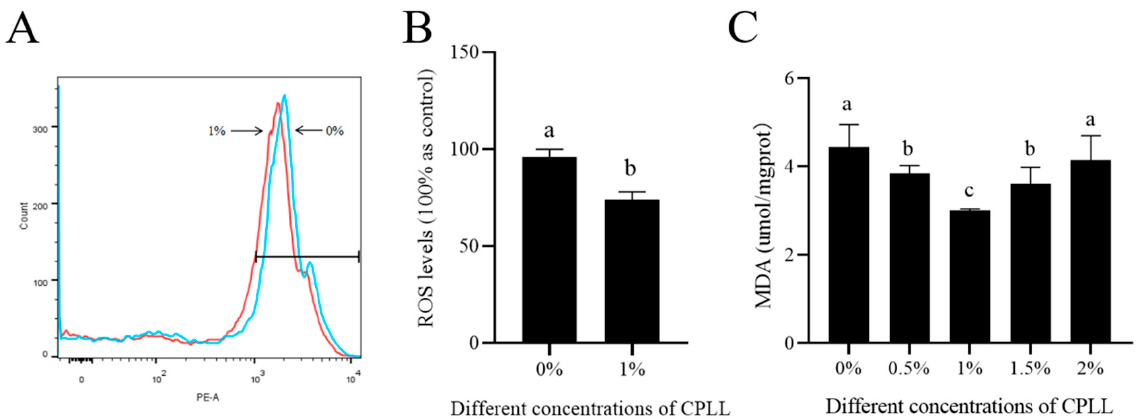
Figure 3. Effects of CPLL on goat sperm ROS content and MDA level after freezing-thawing. ( A ) Flow cytometer peak for ROS and ( B ) the ROS content compared between 1% CPLL and control. ( C ) The MDA level at different concentrations of CPLL supplemented to the freezing medium.